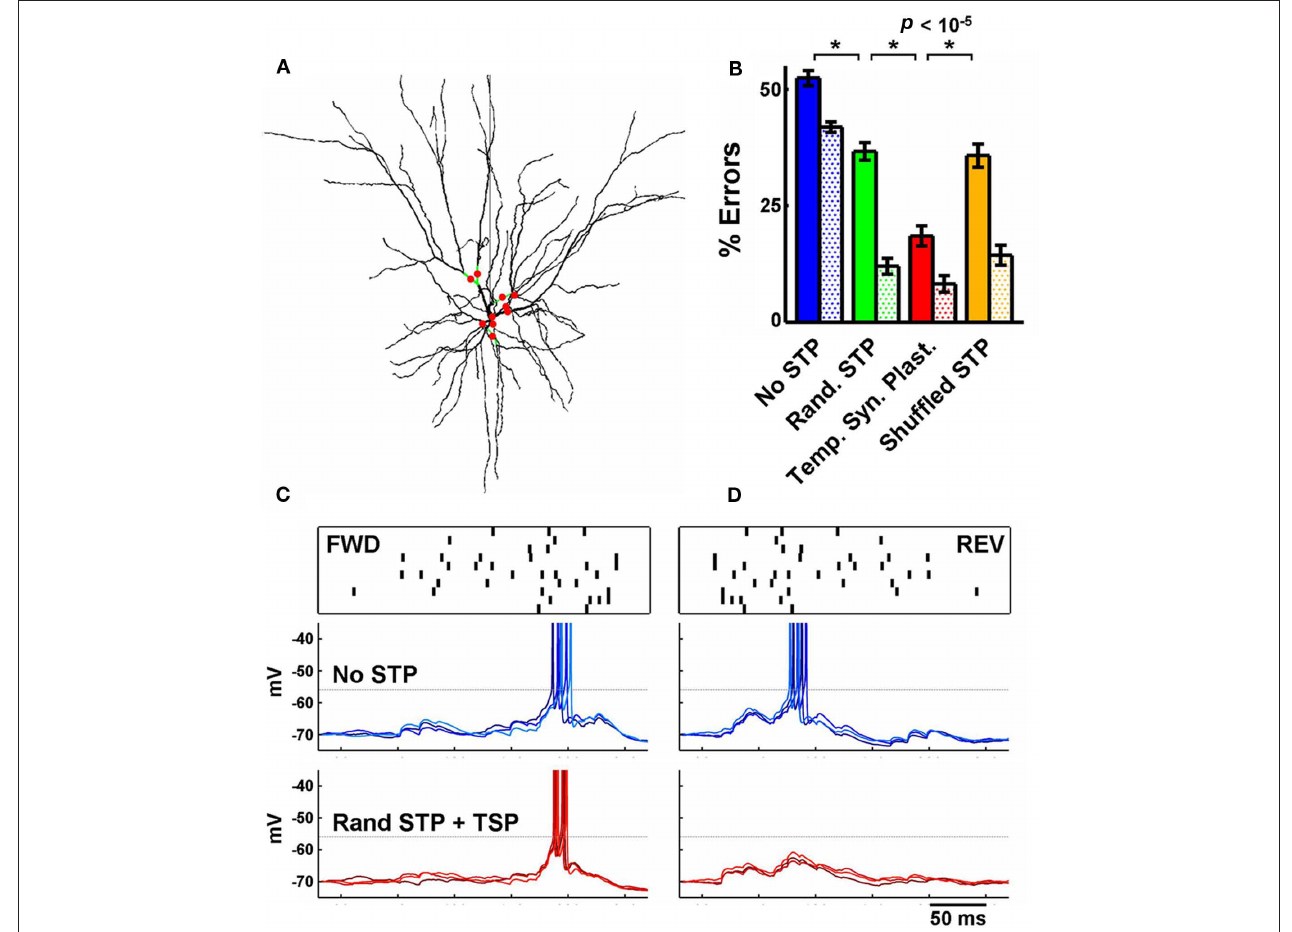
response of the realistic neuron ( C and D ) to three repeated presentations of the stimulus above. Synapses do not exhibit short-term plasticity. Bottom row: as above, but synapses exhibit STP, whose parameters were adjusted by the temporal synaptic plasticity learning rule during training. Notice the effectiveness of temporal synaptic plasticity in preventing the neuron to fire to the reverse pattern. This neuron fires in short bursts of doublets and the horizontal dotted line indicates the approximate action